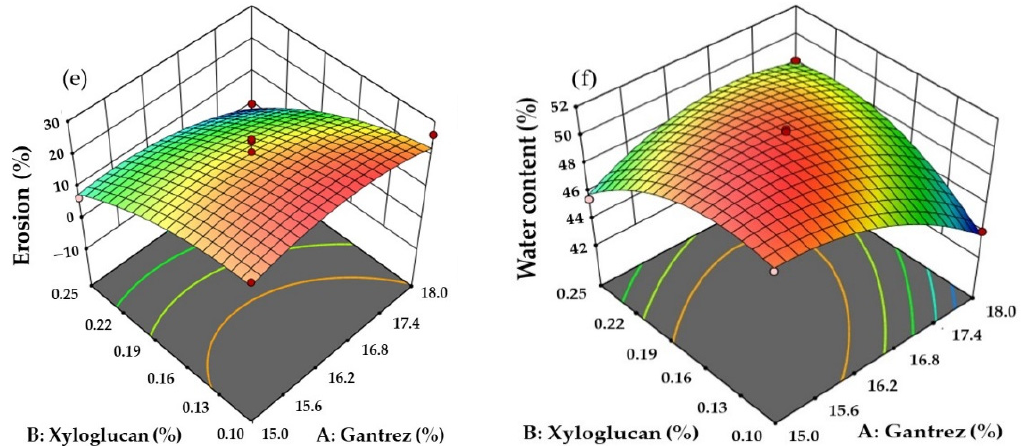
Figure 1. The 3D response surface plots of outputs: ( a ) water absorption, ( b ) tensile strength, ( c ) Young’s modulus, ( d ) elongation, ( e ) erosion, and ( f ) water content.